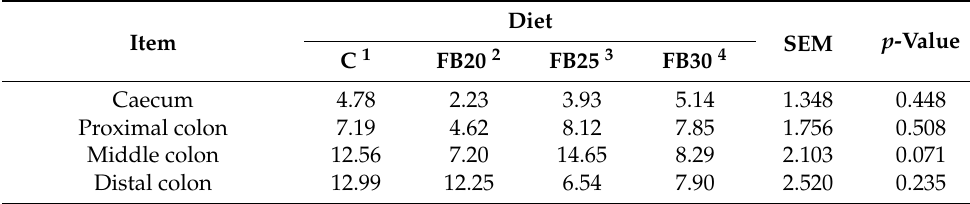
Table 5. Ammonia concentration in the large intestine of pigs fed diets with extruded faba bean seeds, µ mol/g